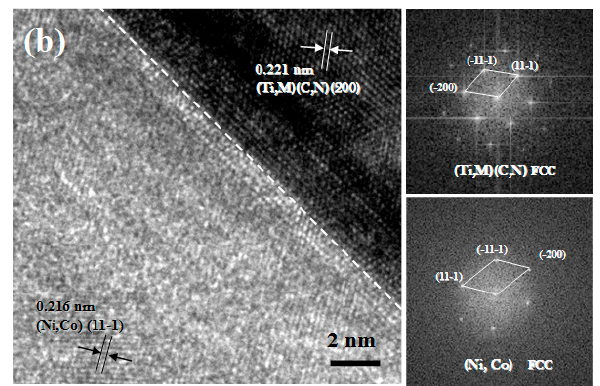
Figure 4. HRTEM micrograph of the core/rim interface ( a ) (corresponding to region A in Figure 1) and the rim/binder phase interface in prepared cermets ( b ) (corresponding to region B in Figure 1).